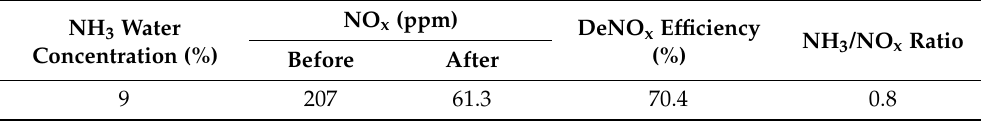
Table 6. NO x removal efficiency of pilot-scale SCR process operation in Korean cement manufacturer G (13% with O 2